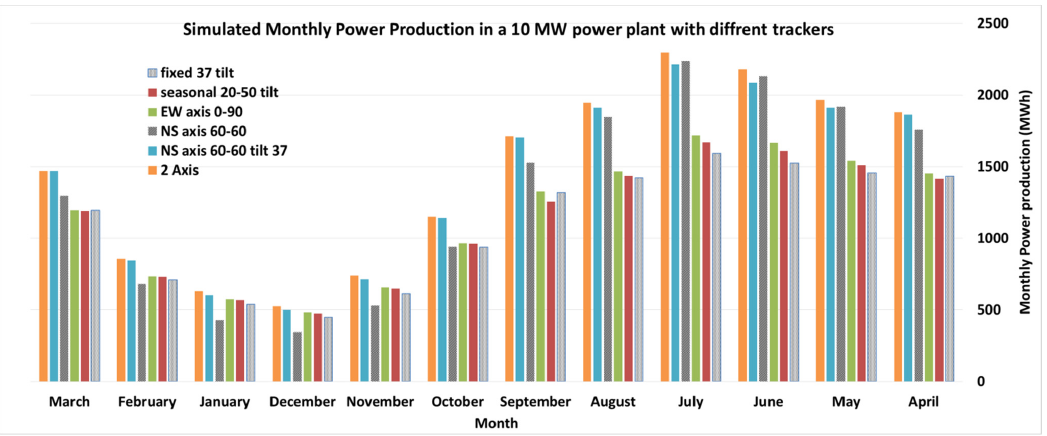
Figure 16. Monthly performance of hypothetical 10 MW power plant in Qom under the different